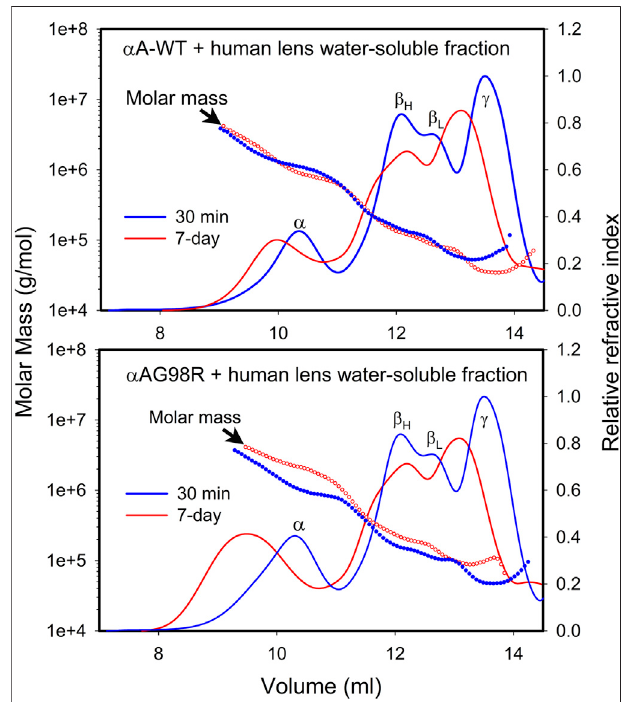
FIGURE 3 | Mass distribution in 16-year old human lens water-soluble extract incubated with α AG98R or α A-WT. The water-soluble lens extract containing 250 µg protein was incubated with 50 µg of the chaperone protein under aseptic conditions in 0.25 ml PBS. At the end of the incubation, thesamplewas fi lteredtoremoveany residues, and150 µlwasinjectedintoa TSKgel G5000PW XL size exclusion column attached to a Shimadzu HPLC system with a RI detector. The mobile phase contained 0.05 M sodium phosphate and 0.15 M sodium chloride, pH 7.2. The eluting proteins were analyzed with the help of WYATT MALS-DLS prominent peak ( Figure 5 upper panel — blue), with 80% of the protein recovered in the soluble form (compared to the sample analyzed at 0 min). The average molar mass of the soluble α AG98R oligomers decreased from 9,386 kDa to 3,350 kDa in the presence of MGO at 7 days ( Table 2 ). The hydrodynamic radii also showed a similar decrease in size ( Table 2 ). The elution pro fi le of α AG98R without MGO at 0 min (shown in black dash line for comparison) had an average oligomer mass of 2057 kDa (data not shown). Unlike signi fi cant reduction in M w and R h . The average M w of α A-WT